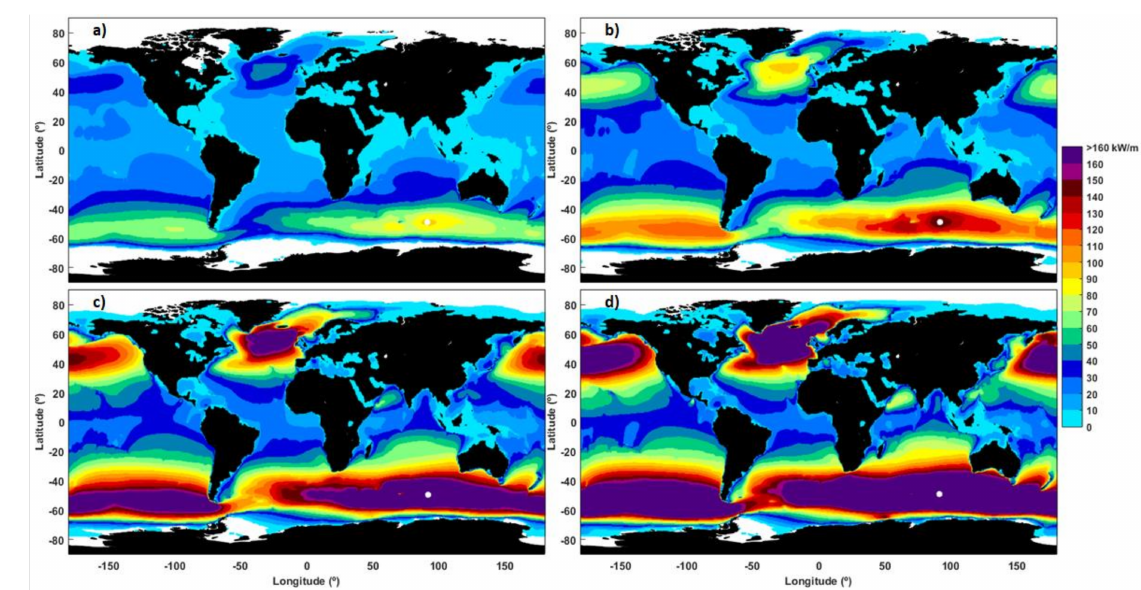
Figure 2. Wave power percentiles based on ERA5 data over the 30-year time interval (1989–2018): ( a ) 50th percentile, ( b ) 75th percentile, ( c ) 90th percentile, ( d ) 95th percentile.